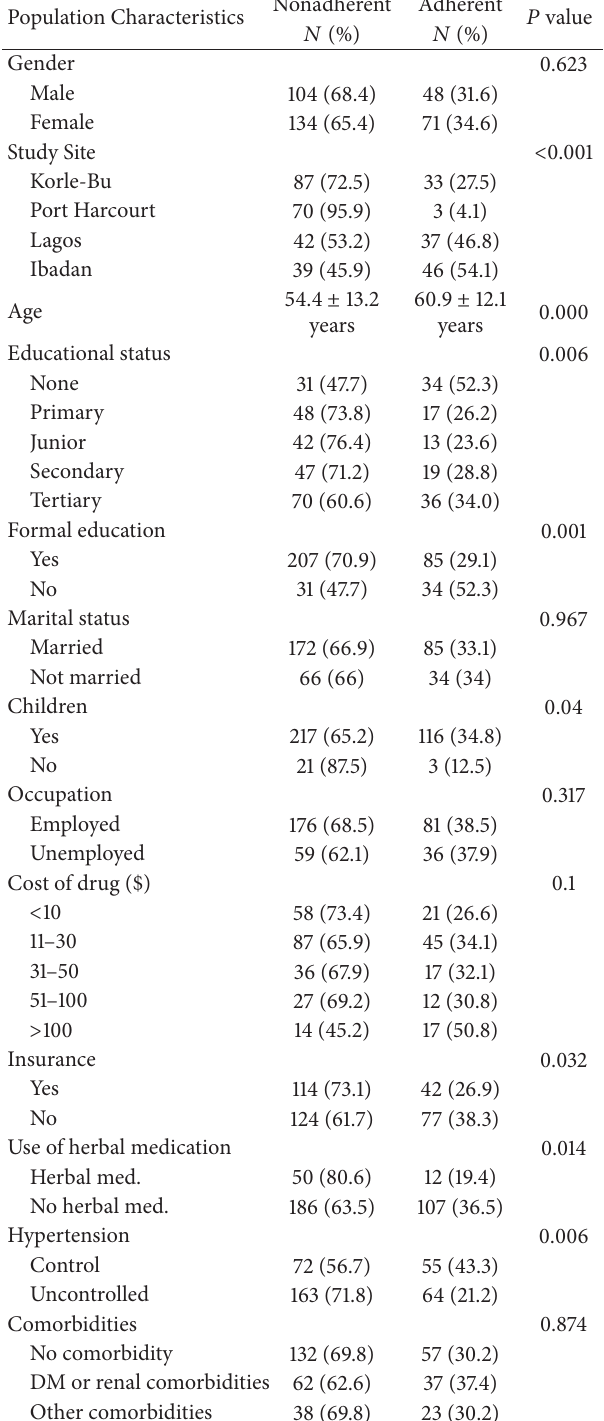
Table 3: Distribution of study population characteristics by adher- ence ( 𝑁 = 357